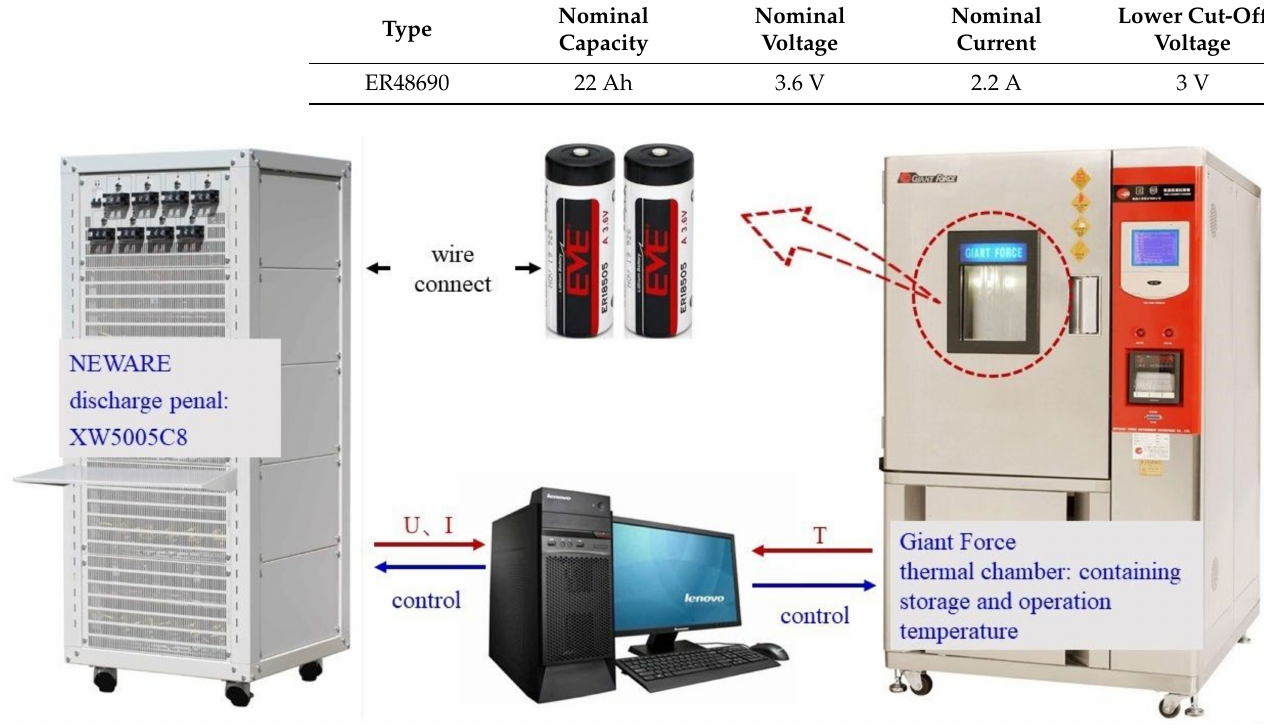
Table 2. The basic parameters of the tested battery system, i.e., ER48690.